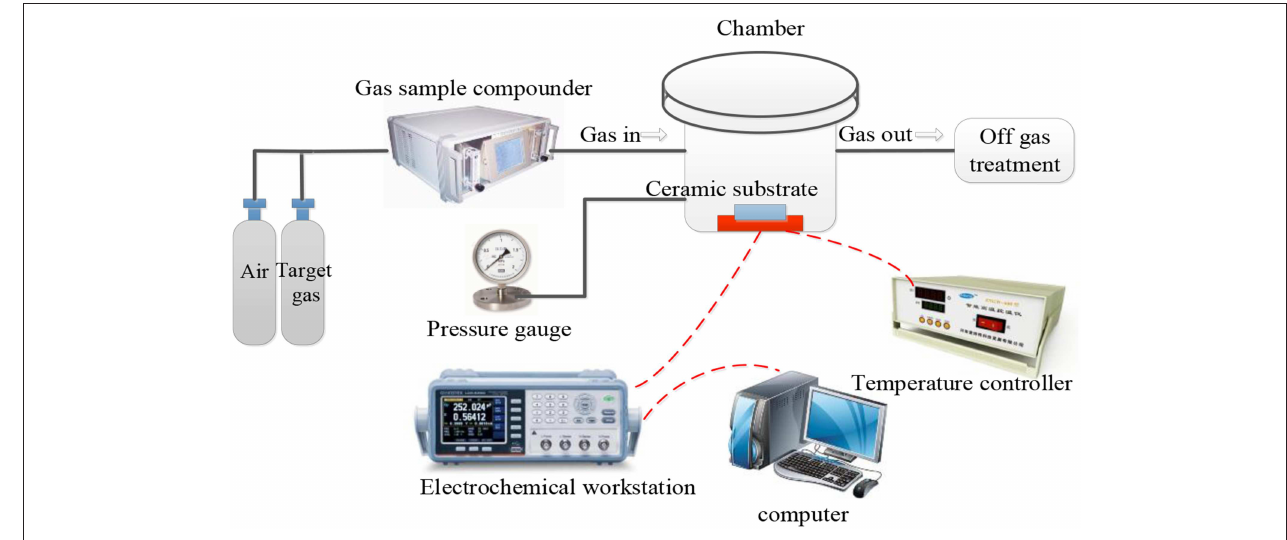
FIGURE 2 | Measurement system for gas sensing